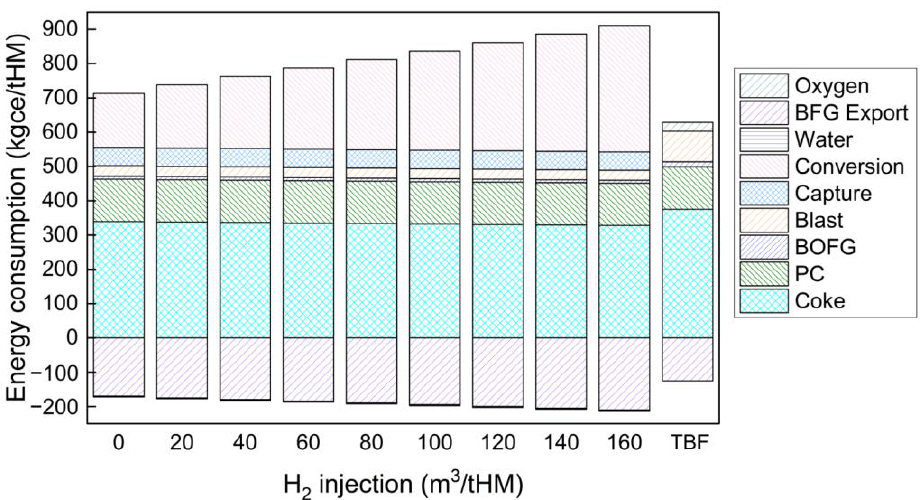
Figure 12. Energy consumption for H 2 -rich gas injection BF and traditional BF process (energy carried by the make-up water needed for the CO 2 conversion and by BOFG was less than 1% of total energy consumption and thus not indicated in this figure).